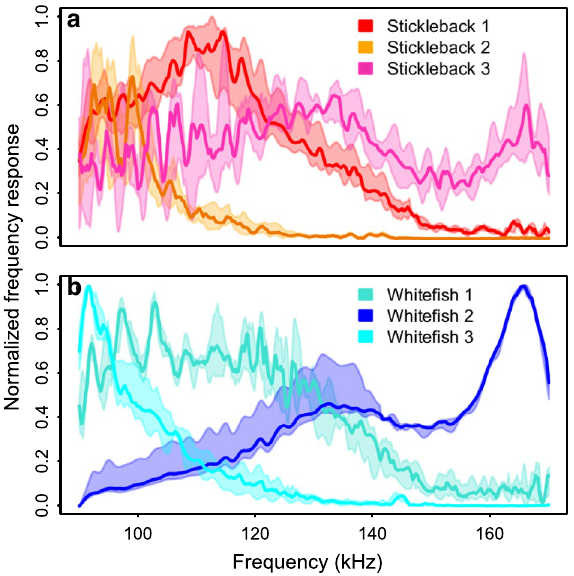
Figure 3. Variation in relative frequency response curves (FRC) from three individual sticklebacks and whitefish. The bold line is the median and the shaded polygon region includes the 25–75 percentiles for observations from each fish, where overlapping regions are shown by the combined